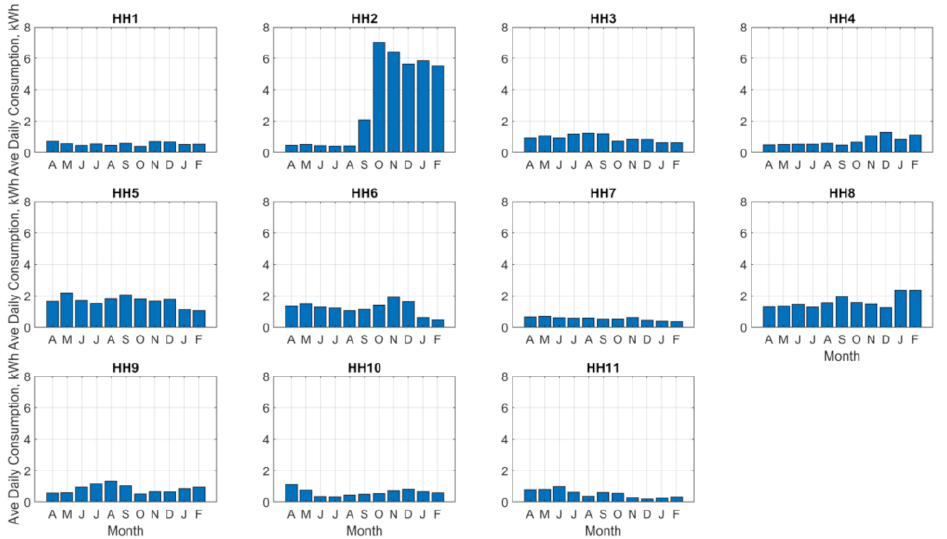
Figure 18. Average daily kWh consumption on monthly basis from April 2020 to February 2021 of households in the Gilutongan Island solar